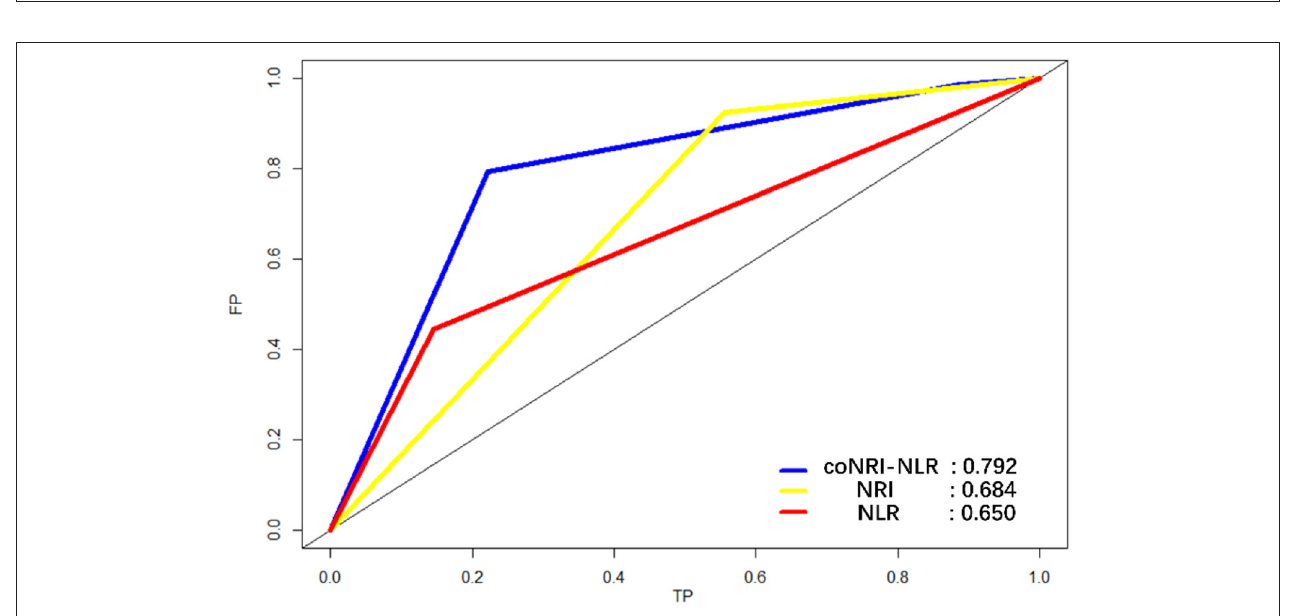
FIGURE 3 | Receiver operating characteristic curve (ROC) analysis for the sensitivity and specificity of the model coNRI-NLR, NRI, and